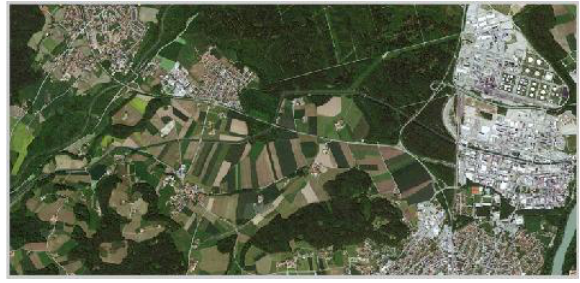
Figure 2. Input image for the